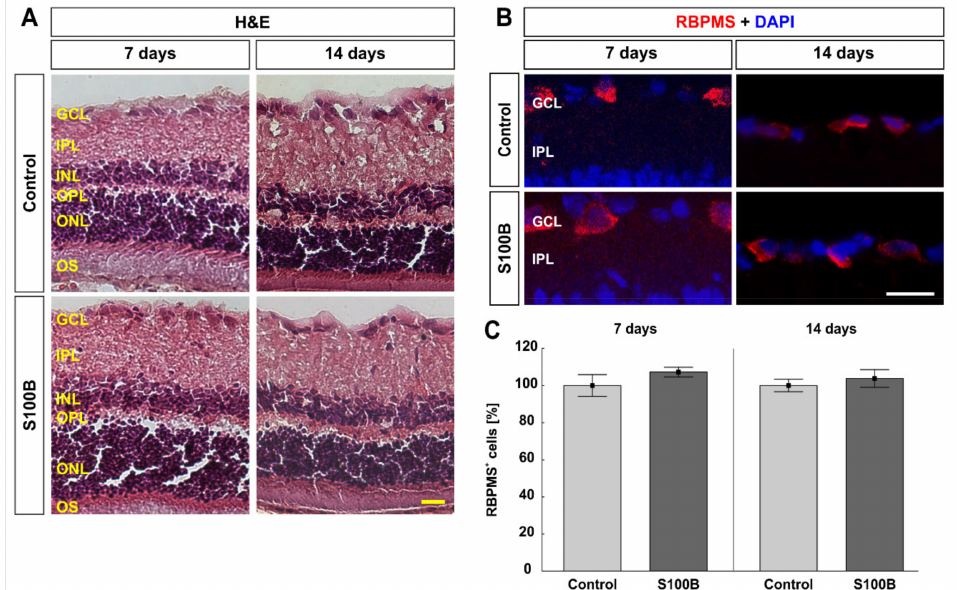
Figure 5. Intact retinal morphology and no retinal ganglion cell loss. ( A ) At 7 and 14 days after S100B immunization, the retinae showed no signs of inflammation or damage of the retinal layers. The morphology was comparable to those of the control group. ( B ) At 7 and 14 days after immunization, retinal cross-sections were labeled with an antibody against RBPMS (red; retinal ganglion cells). DAPI was used for counterstaining cell nuclei (blue). ( C ) The number of RBPMS + cells remained